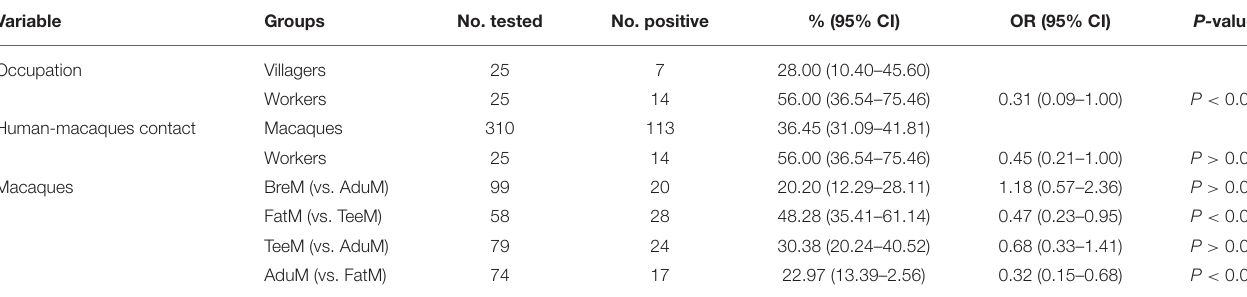
TABLE 2 | Prevalence and risk factors for intestinal protozoan infections in humans and macaques.